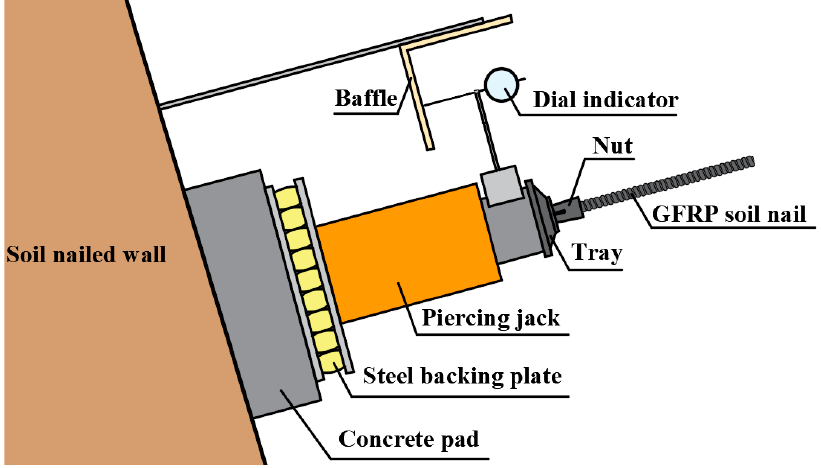
Figure 4. Schematic diagram of field loading test device.